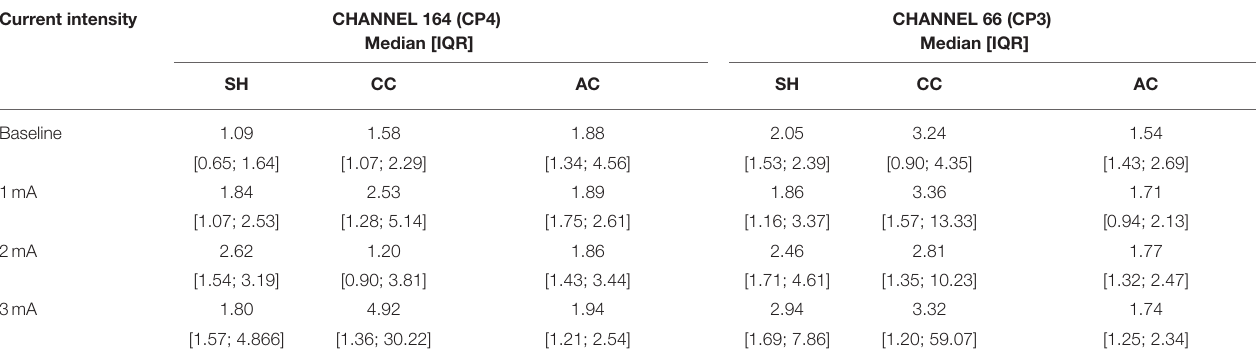
CHANNEL 66 (CP3) Median [IQR]